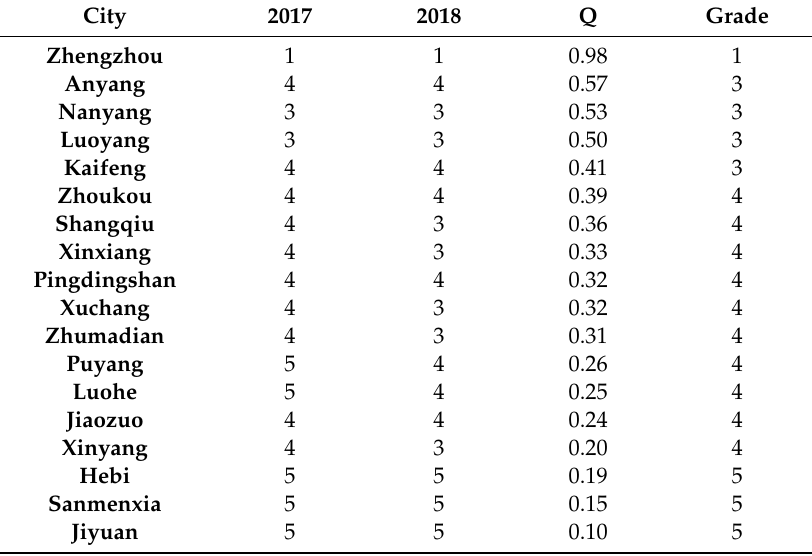
Figure 11. The results of Henan Province city grade classification. Table 5. The results of this paper are compared with those of China.